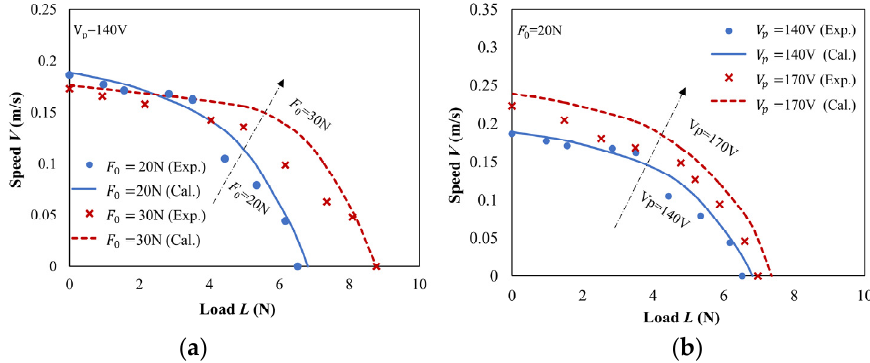
Figure 15. Comparison illustration of theoretical and experimental curves of mechanical characteristics for ultrasonic motors under different working conditions: ( a ) preload and ( b ) applied voltage.